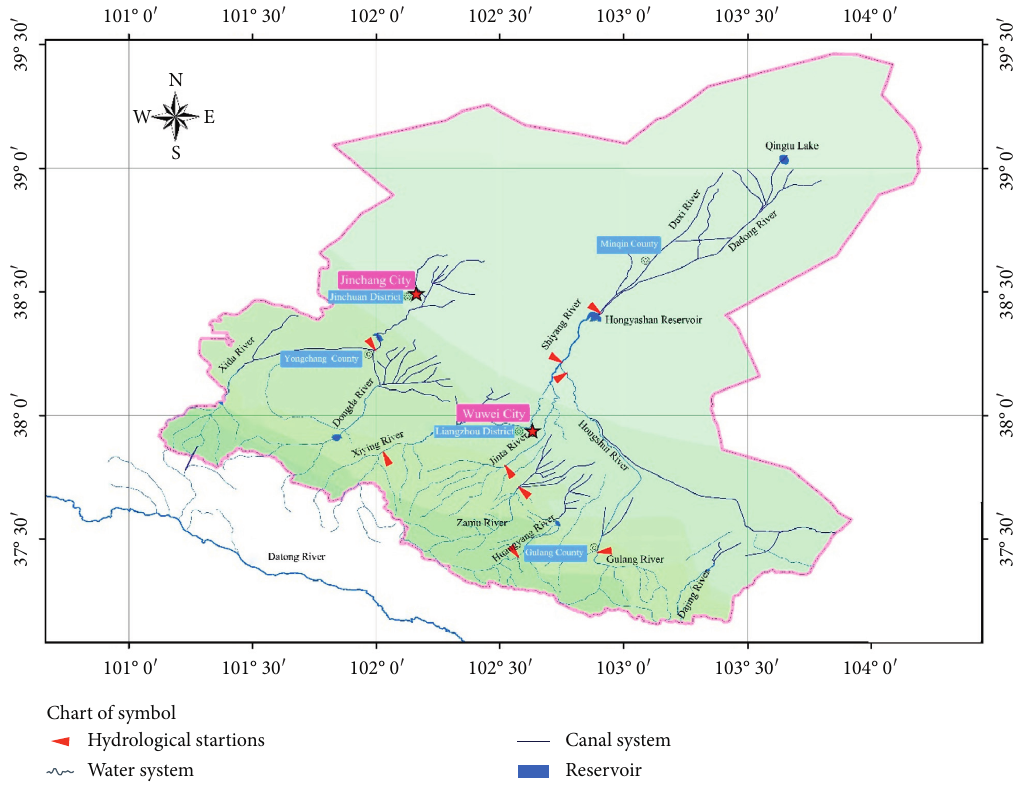
Figure 1: Map of the Shiyang